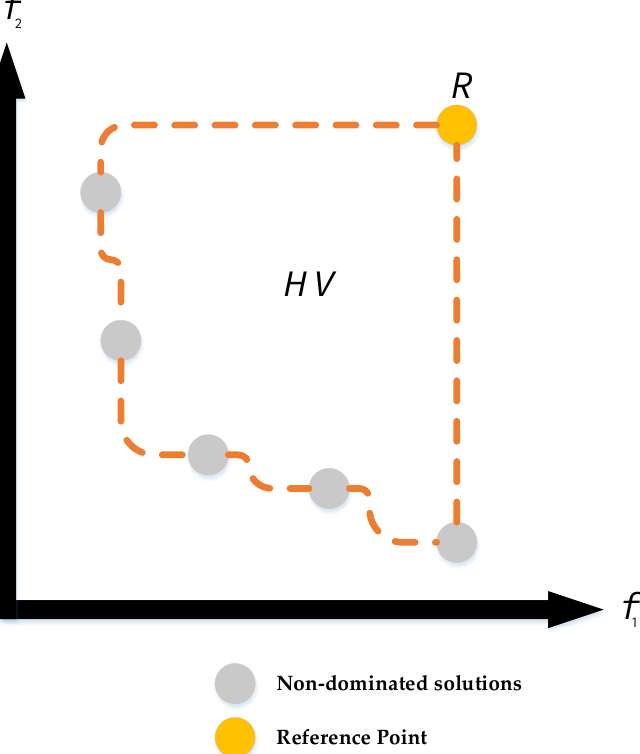
Figure 8. Hyper volume enclosed by nondominated solutions and the reference point.